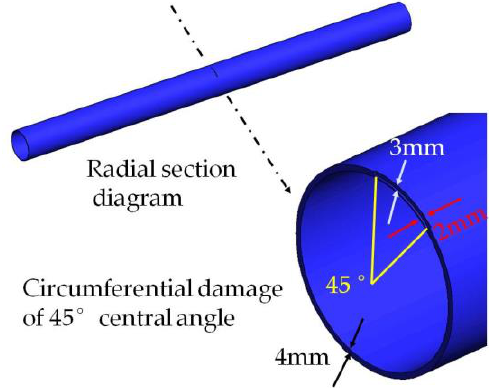
Figure 11. The cross-section of circumferential damage with a radius angle of 45°.